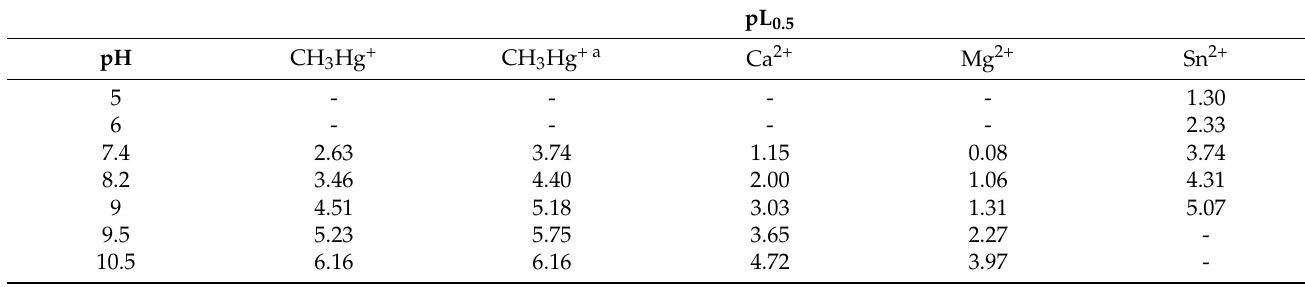
Table 13. Sequestering ability of dopamine towards metal ions at I = 0.15 mol dm − 3 , T = 298.15 K and different pHs.